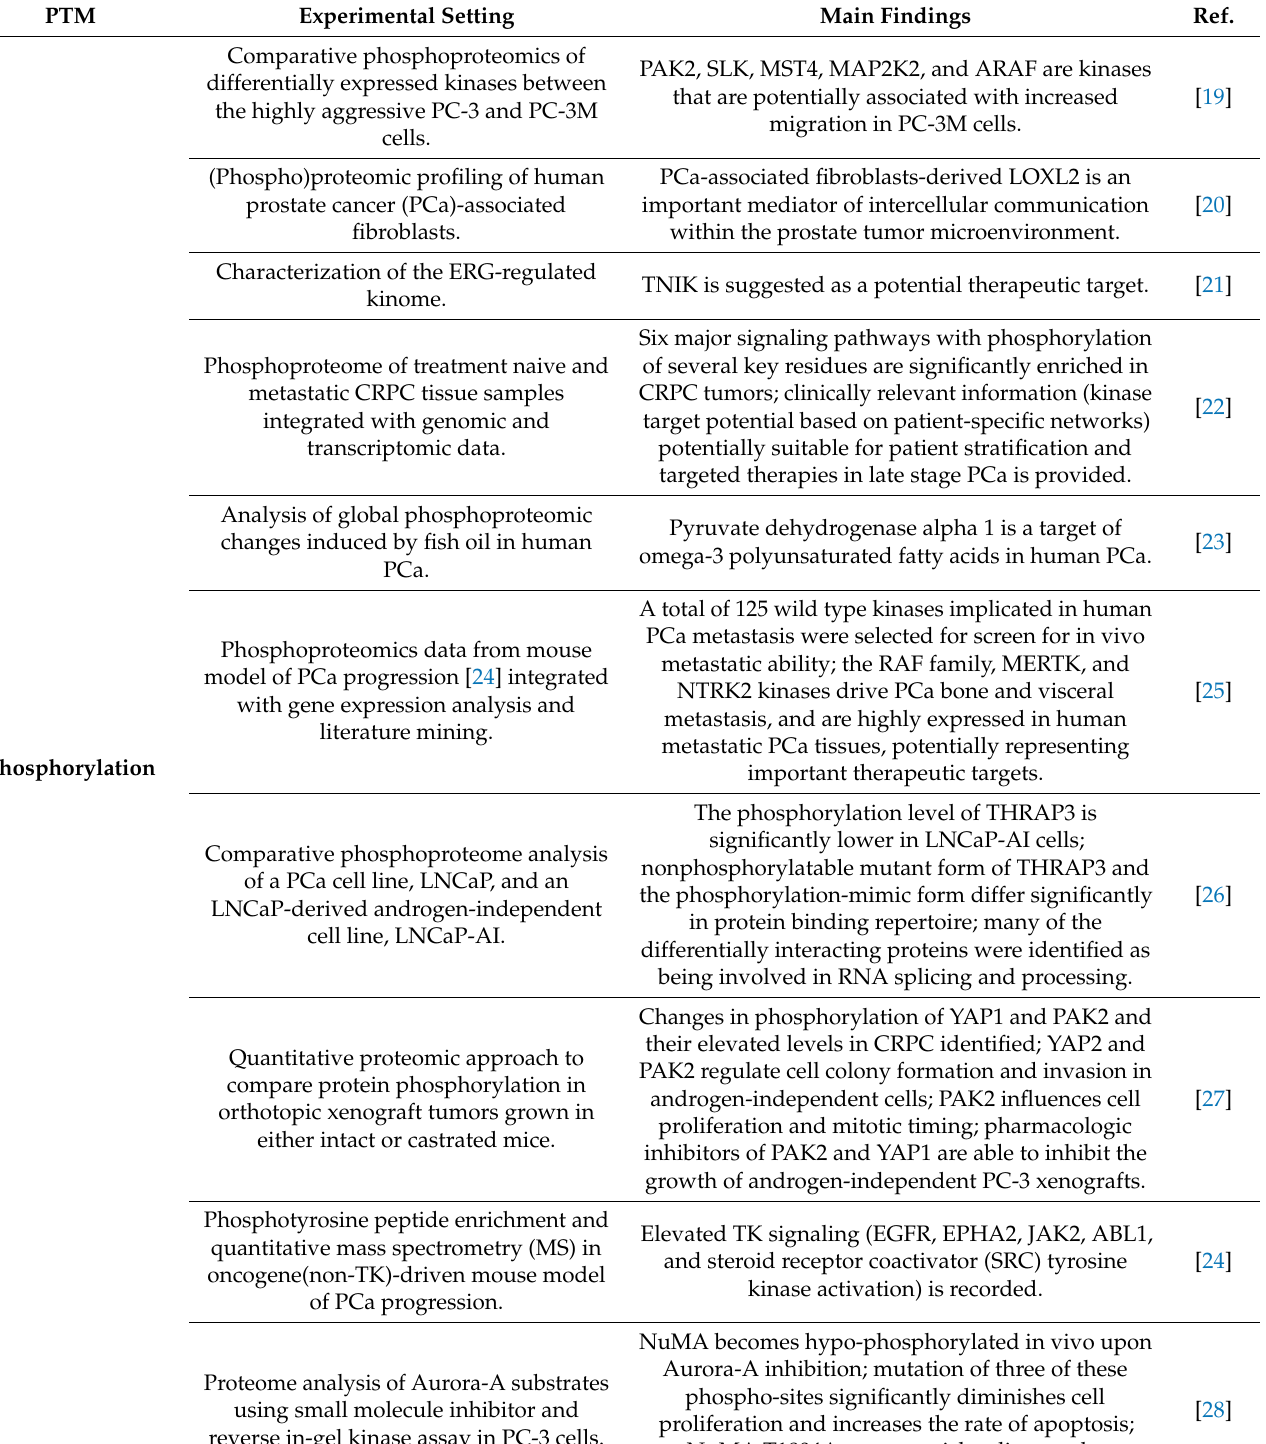
Table 1. Findings from proteome studies on post-translational modifications that influence prostate cancer cell fate.